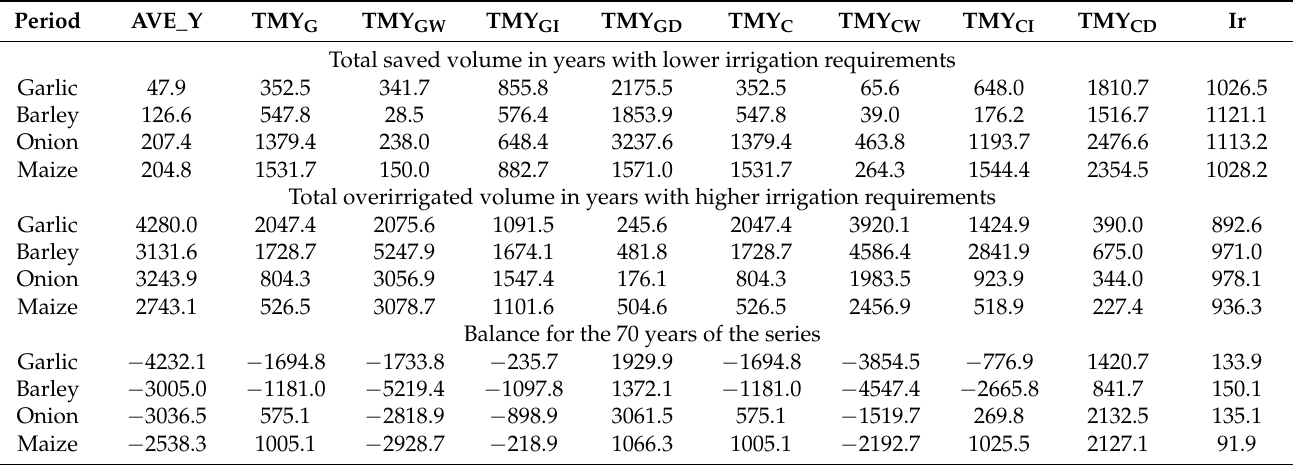
Table 7. Balance between the volume of irrigation water supplied in years with higher or lower irrigation requirements than assigned